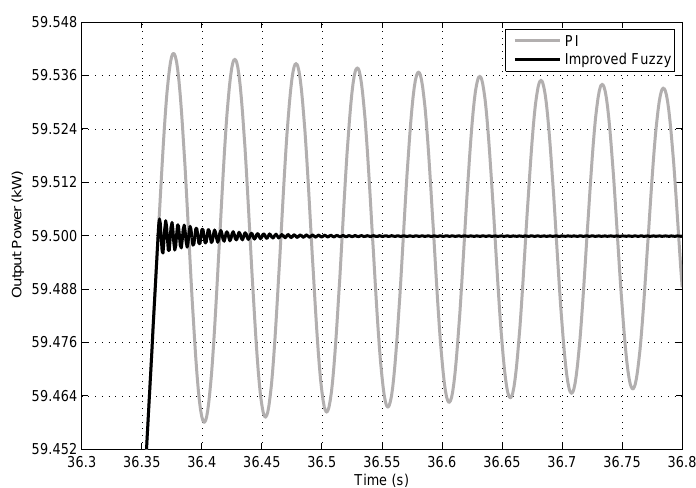
Figure 14. Comparison between the improved fuzzy and PI controller output powers.